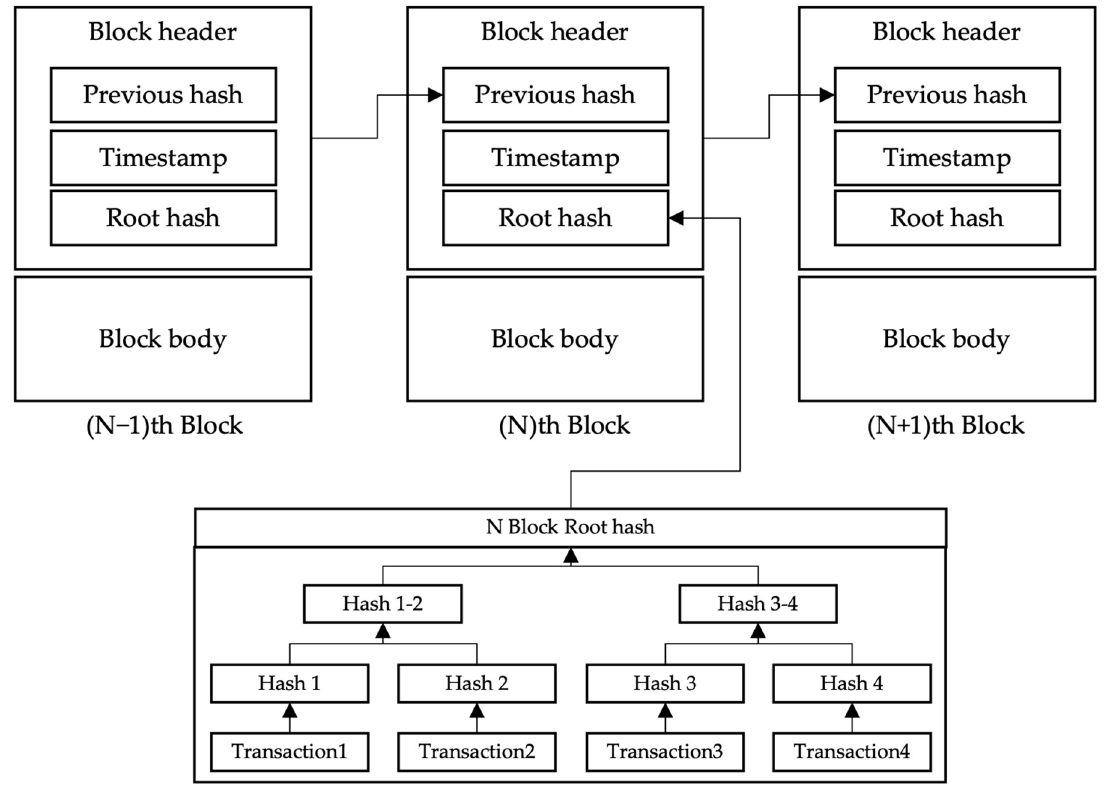
Figure 1. Blockchain Header Structure.